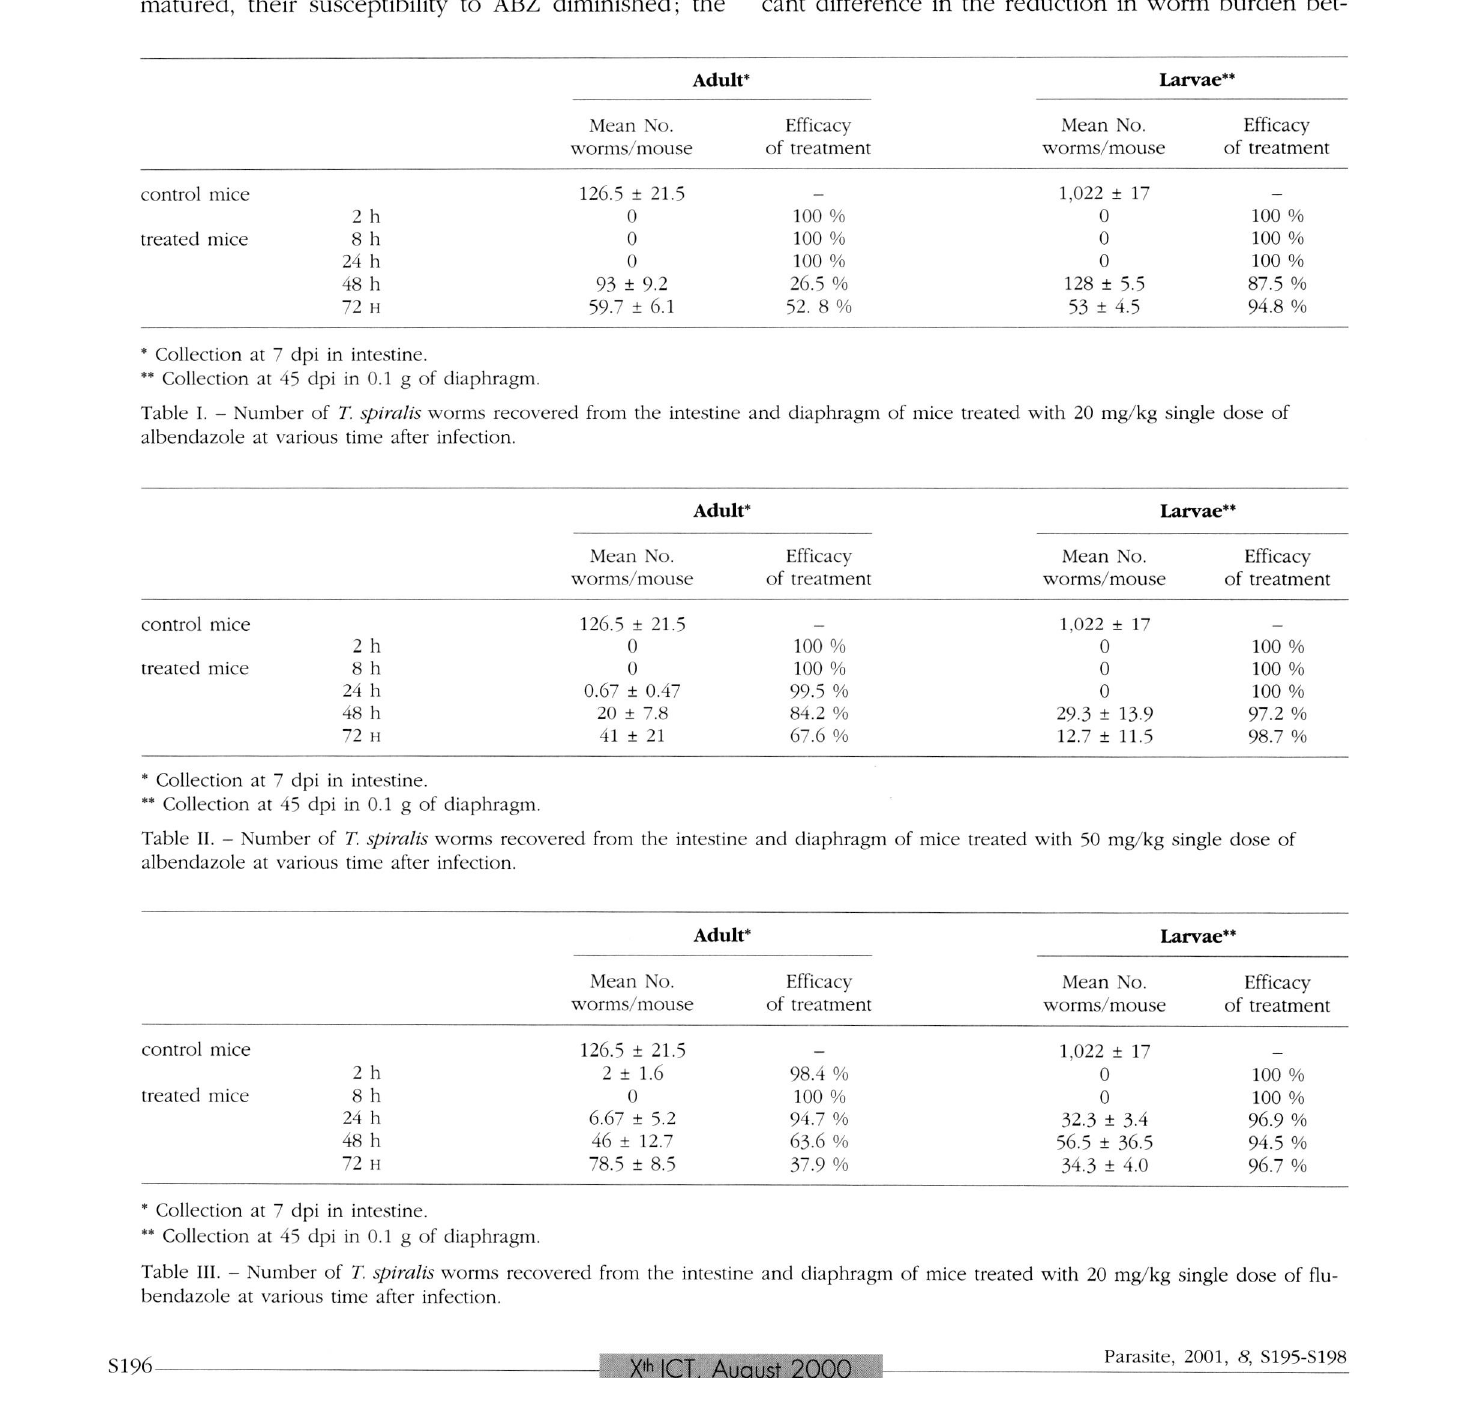
Table I. - Number of T . spiralis worms recovered from the intestine and diaphragm of mice treated with 20 mg/kg single dose of albendazole at various time after infection.